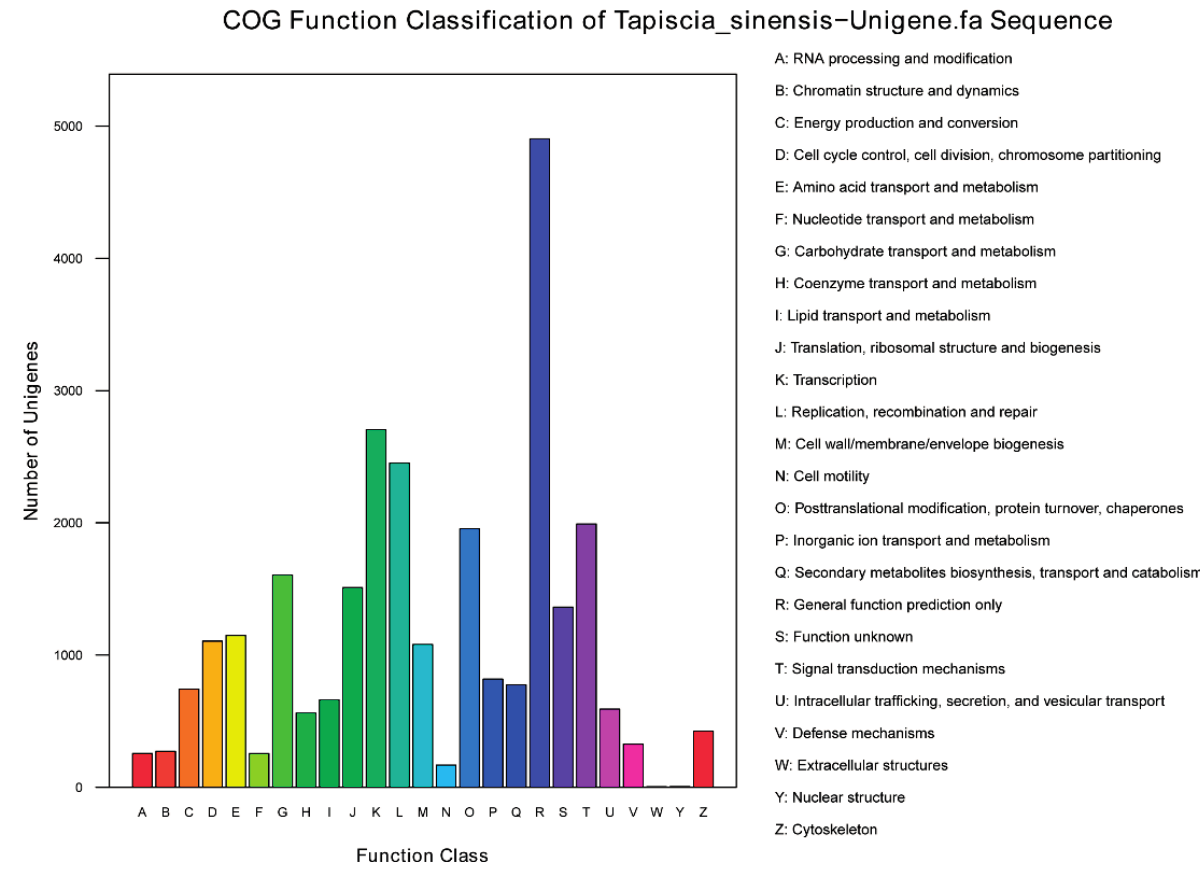
Figure 4. Unigenes were assigned to COG